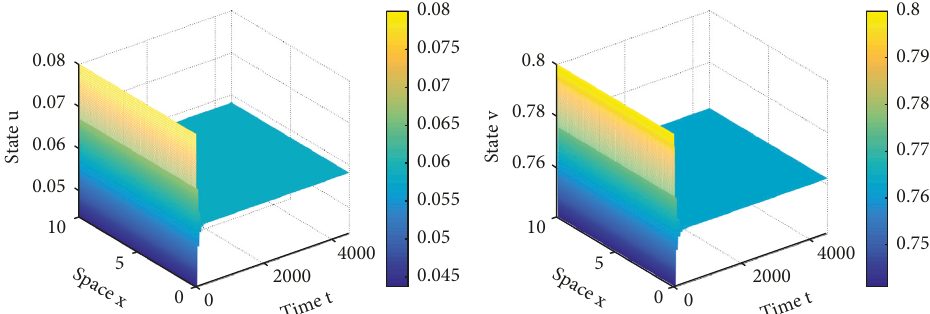
Figure 7: The evolution process of node u ( t ) and v ( t ) in system (9) when D